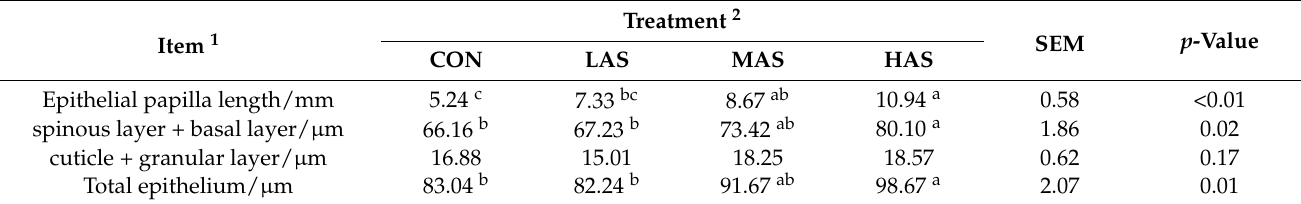
Table 6. Effect of high sulfur diet on the thickness of different cellular stratum of rumen epithelium. Item